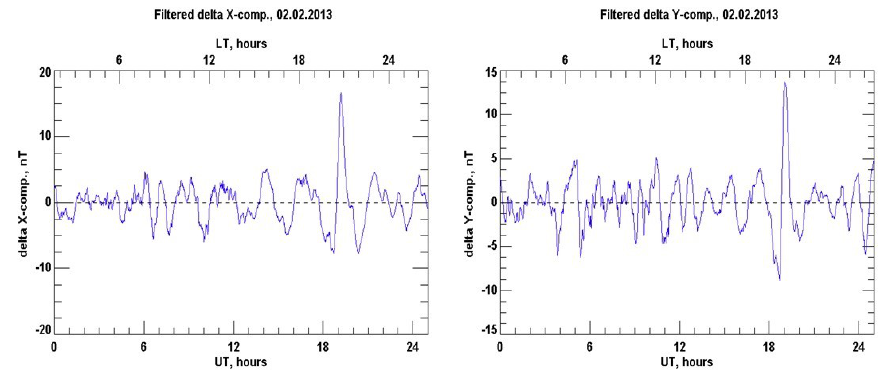
Fig.5. Processed X (left panel) and Y (right panel) components of the magnetic field, measured on 02 February 2013 at the Panagjurishte